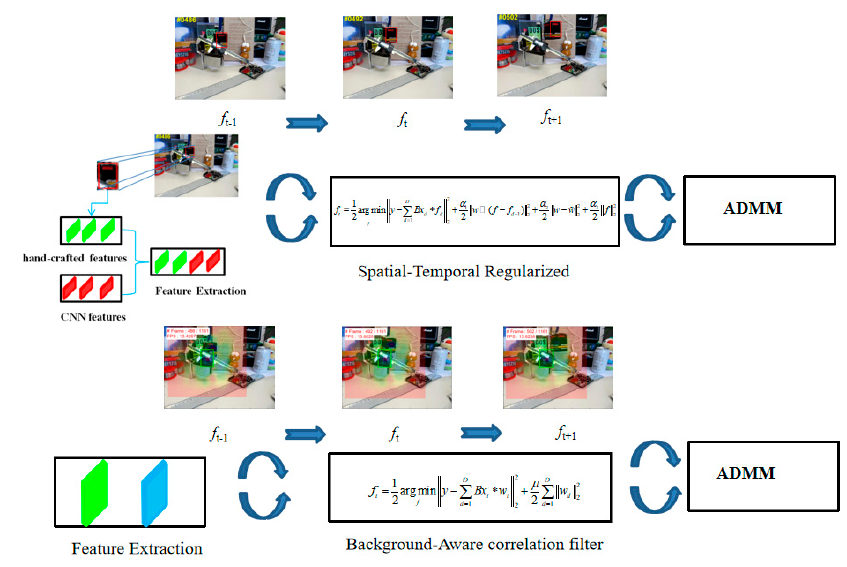
Figure 1. The systematic work-flow of the proposed tracking algorithm.